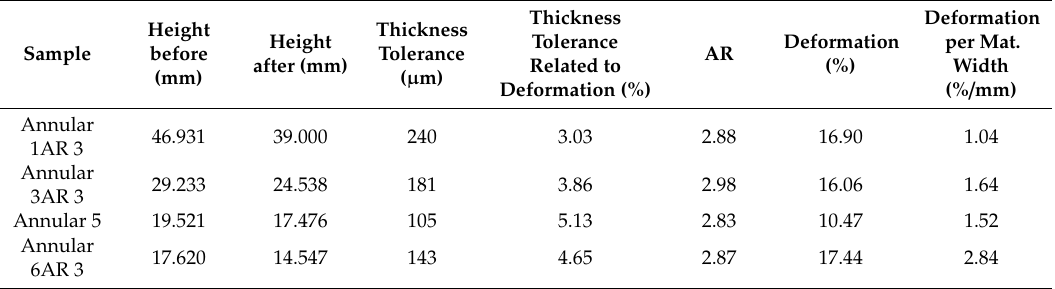
Table 7. Deformation of selected annular samples with an aspect ratio of three.